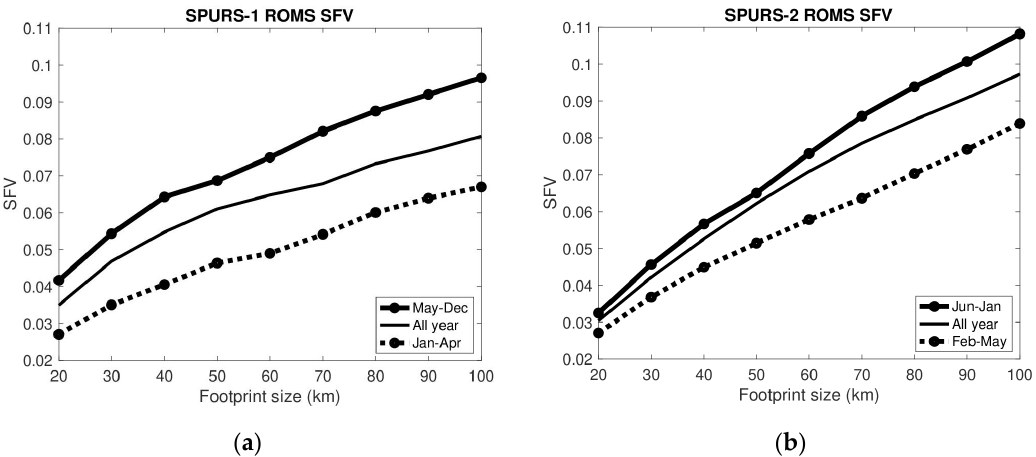
Figure 10. ( a ) As in Figure 4, but with SFV computed from the ROMS simulation. ( b ) As in Figure 3b, but with SFV computed from the ROMS simulation. Light black curves are the same as those displayed in Figure 8.